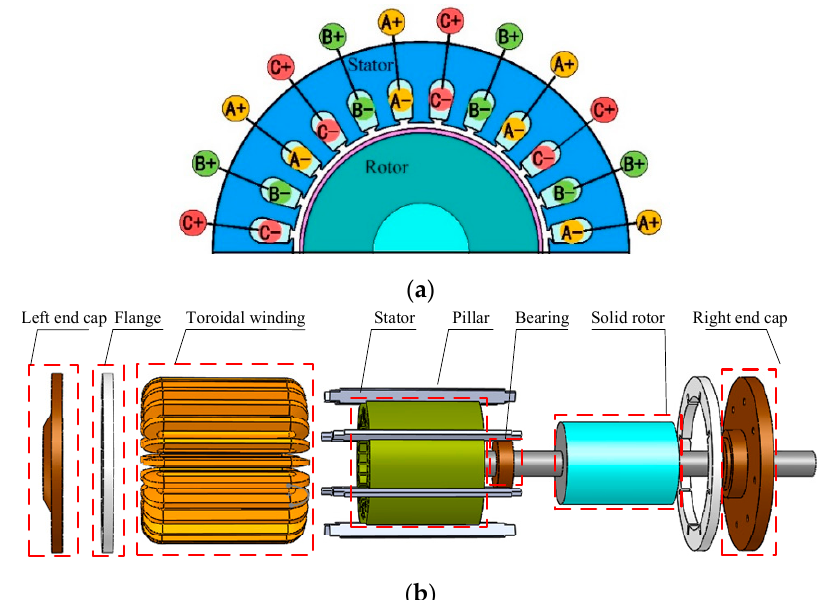
Figure 1. Novel solid rotor induction motor with toroidal winding (N-TWSRIM): ( a ) phase winding diagram; ( b ) N-TWSRIM structure.